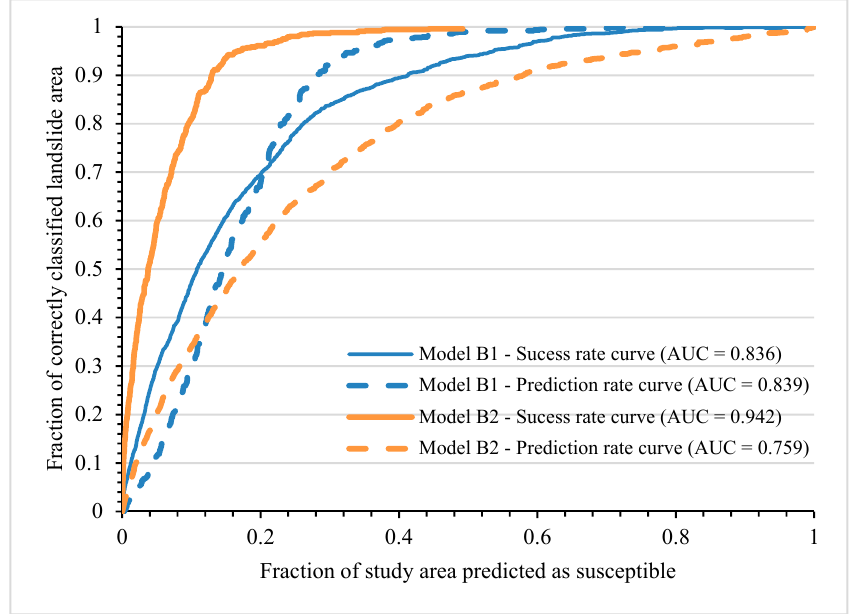
Figure 11. Success and prediction rate curves of landslide susceptibility Models B1 and B2.